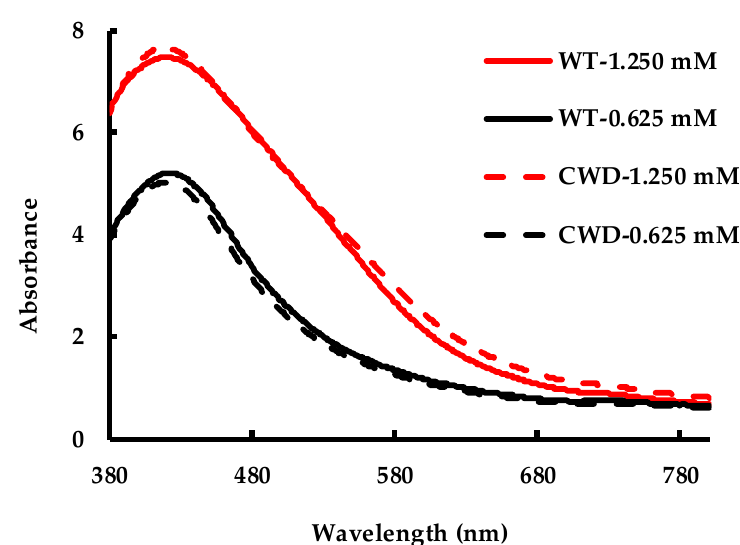
Figure 2. Spectrophotometric measurements of WT and CWD strains at 1.250 mM and 0.625 mM AgNO 3 concentrations at 192 h.